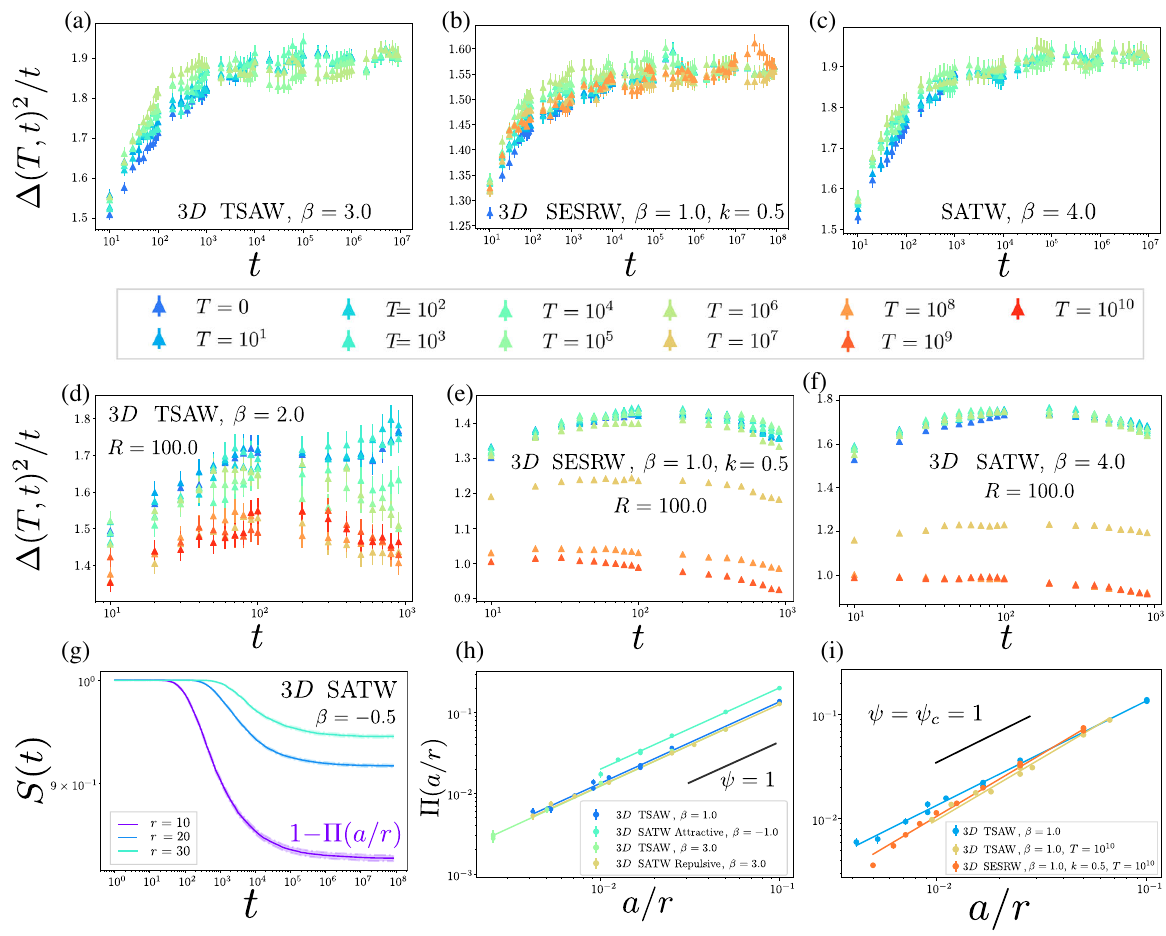
FIG. 4. Aging and first-passage properties for noncompact self-interacting random walks in infinite space and in confined geometries. (a) Aging of the increments for the 3 d TSAW, (b) the 3 d SESRW, and (c) the 3 d SATW in infinite space (increments are normalized by the expected diffusive scaling at long times). Note that the increments are stationary at timescales T ≫ 1 as shown by the collapse of all curves. In contrast, in confined geometries, aging occurs at longer timescales, ≳ R d , for (d) the TSAW, (e) the SESRW, and (f) the SATW (increments are normalized by the expected diffusive scaling at long times). (g) For noncompact random walks (here, the 3 d diffusive SATW), the survival probability tends, for t → ∞ in infinite space, to a nonzero value 1 − Π , which defines the hitting probability that depends on the initial distance to the target r and the target radius a . Hitting probability and transience exponent in infinite space (h) and in confined domains (i) [in this case, the hitting probability is defined in the regime R d w ≫ t ≫ 1 according to Eq. (14)]. Numerical 1 for the TSAW, the SESRW, and the simulations (symbols) and power-law fits (solid lines). Our numerical results indicate ψ ¼ ψ c ¼ SATW, in agreement with the asymptotic diffusive behavior of noncompact self-interacting random